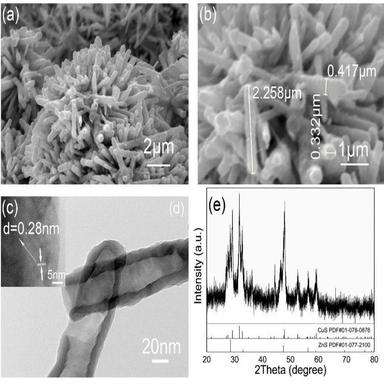
(a, b) SEM image of hollow copper sulfide; (c) HRTEM image of hollow copper sulfide; (d) TEM image of hollow copper sulfide; (e) XRD pattern of hollow copper sulfide.